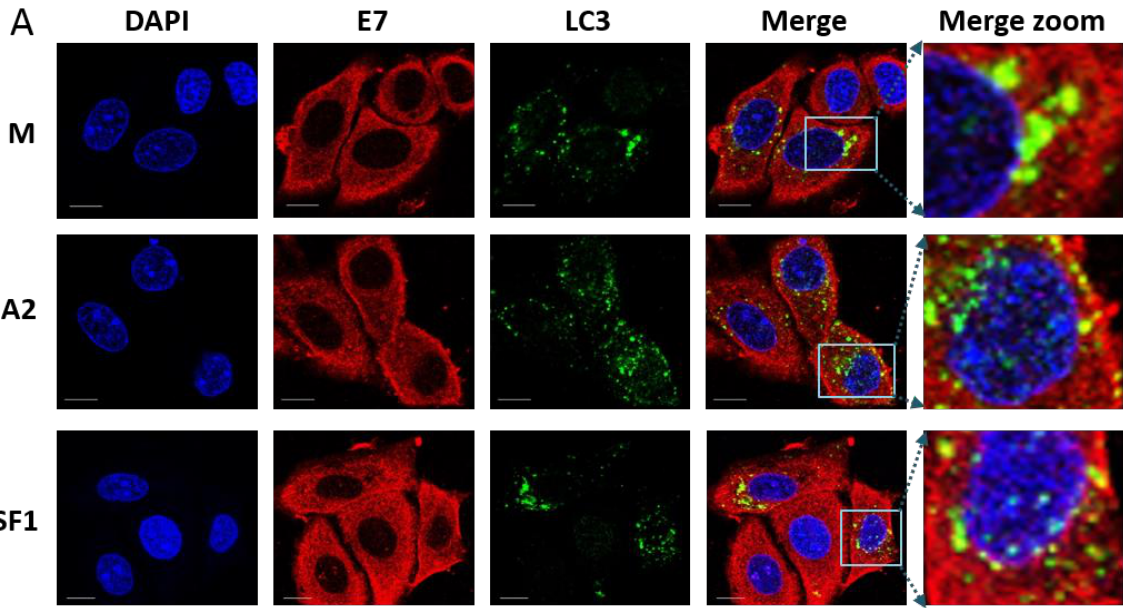
Figure 5. E7 does not co-localise with the early endosomal marker, EEA1 ( A ) or the late endosomal (lysosomal) marker, LAMP1 ( B ). SiHa cells were mock-transfected (M) or transfected with 100 nM A2 or SF1 using Oligofectamine. At 14 h post-transfection, cells were co-stained with either anti-EEA1 or anti-LAMP1 (staining early and late endosomes, respectively) prior to incubation with AlexaFluor488 goat anti-rabbit secondary antibody. Cells were then incubated with anti-E7 antibody (Abcam) followed by AlexaFluor568 rabbit anti-mouse secondary antibody. Red, green and blue are E7, FITC (early or late endosomes) and DAPI (nucleus), respectively. The last panel is a zoom of merged images. The scale bar = 10 µm. E7/EEA1 and E7/LAMP1 colocalisation were analysed using Bitplane:Imeris image analysis software based on the calculation of Pearson’s correlation coefficient values and presented as percentage co-localisation ( C ). n = 27, 23 and 4 for E7/EEA1 and n = 12, 24 and 9 for E7/LAMP-1 in mock-, A2- and SFI-treated SiHa cells, respectively.